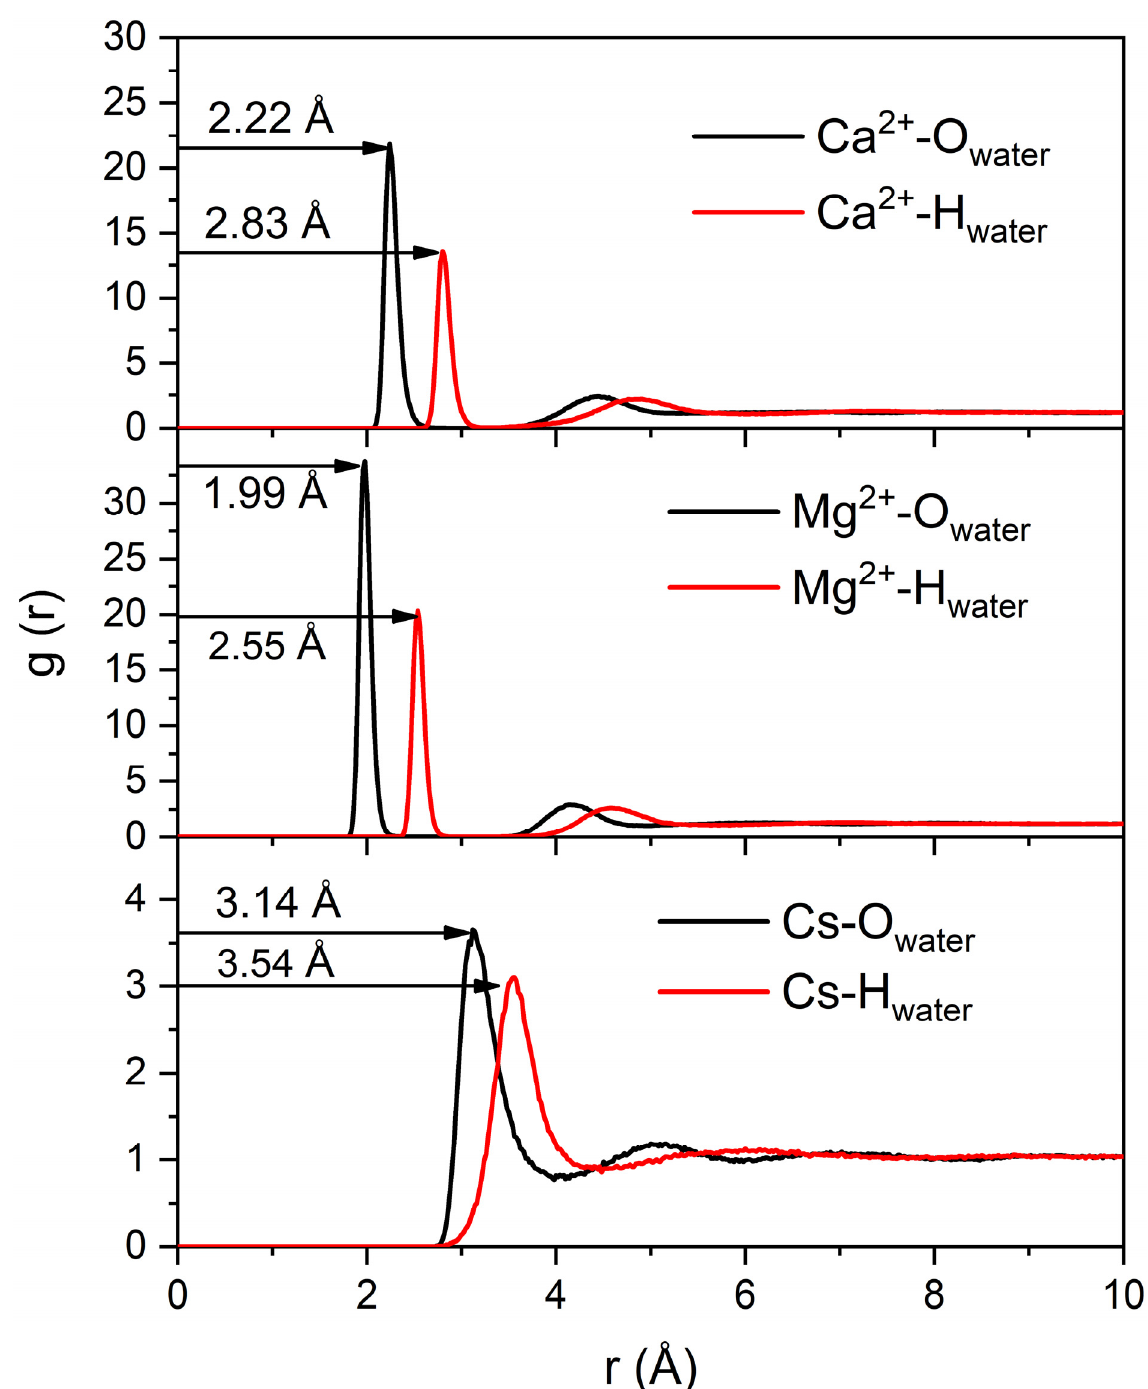
Figure 9. The radial distribution functions (RDF) of cation–water oxygen predicted from MD simu ‐ lations in different laponite suspensions bearing (a) CaCl 2 , (b) MgCl 2 and (c) CsCl